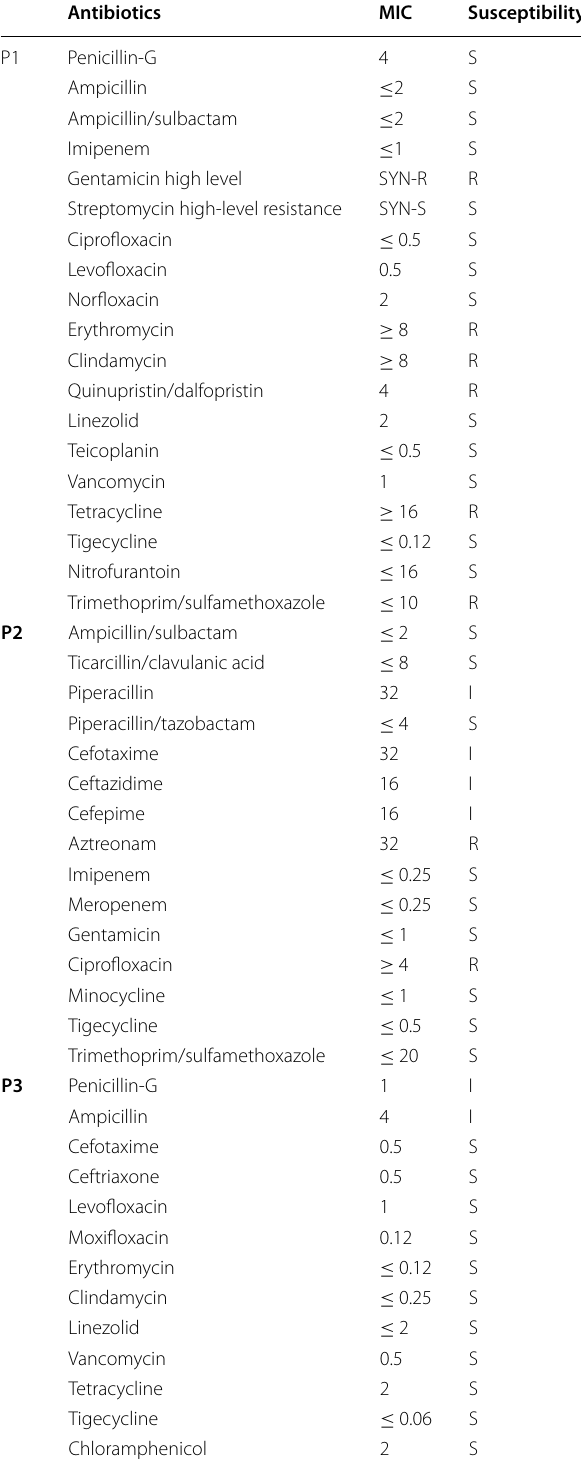
Table 3 Pus culture